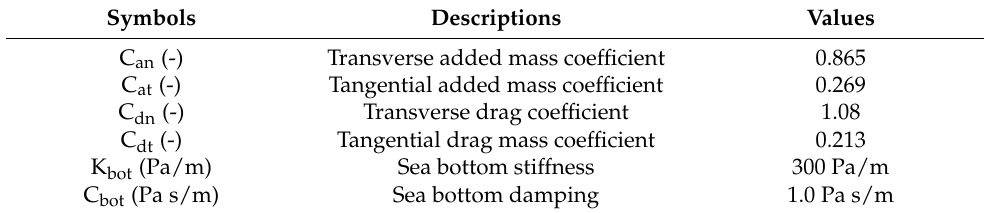
Table 3. Hydrodynamic properties of mooring systems.